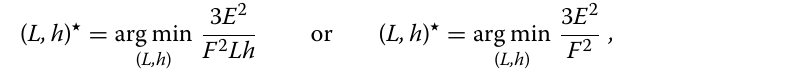
When only one constitutive parameter is considered, the operator whose smallest eigen- value is involved in the cost function of (28) is a scalar which consists in integrating the sensitivity field over the